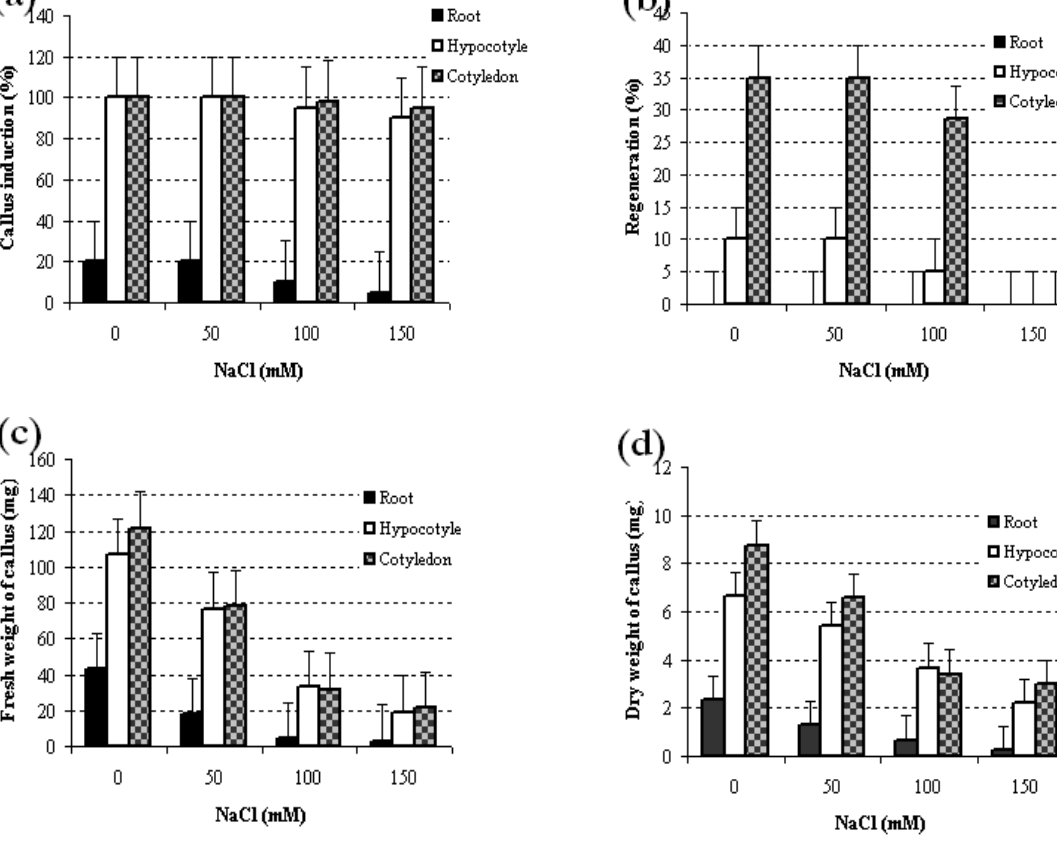
Fig. 4. Interaction effect salinity and explants on (a) callus induction, (b) shoot regeneration, (c) fresh weight and (d) dry weight of Foeniculum vulgare on MS medium containing 1 mg l -1 IAA plus 1 mg l -1 2,4-D and 2 mg l -1 kinetin (media